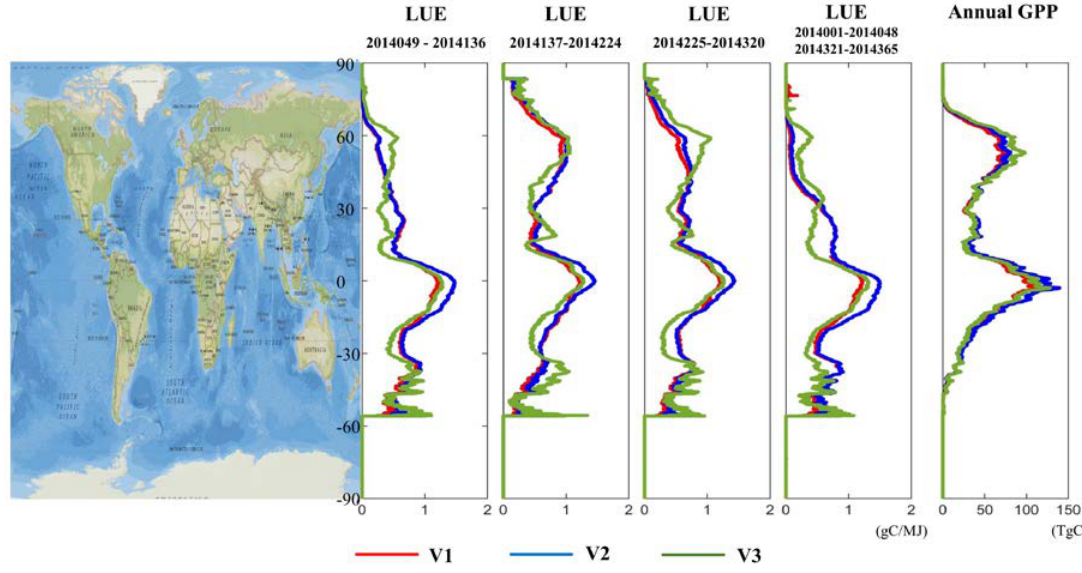
Figure 11. LUE and GPP curves along latitude. V1: Parameterization approach without the CI; V2: Parameterization approach with the CI; V3: Cubist regression tree